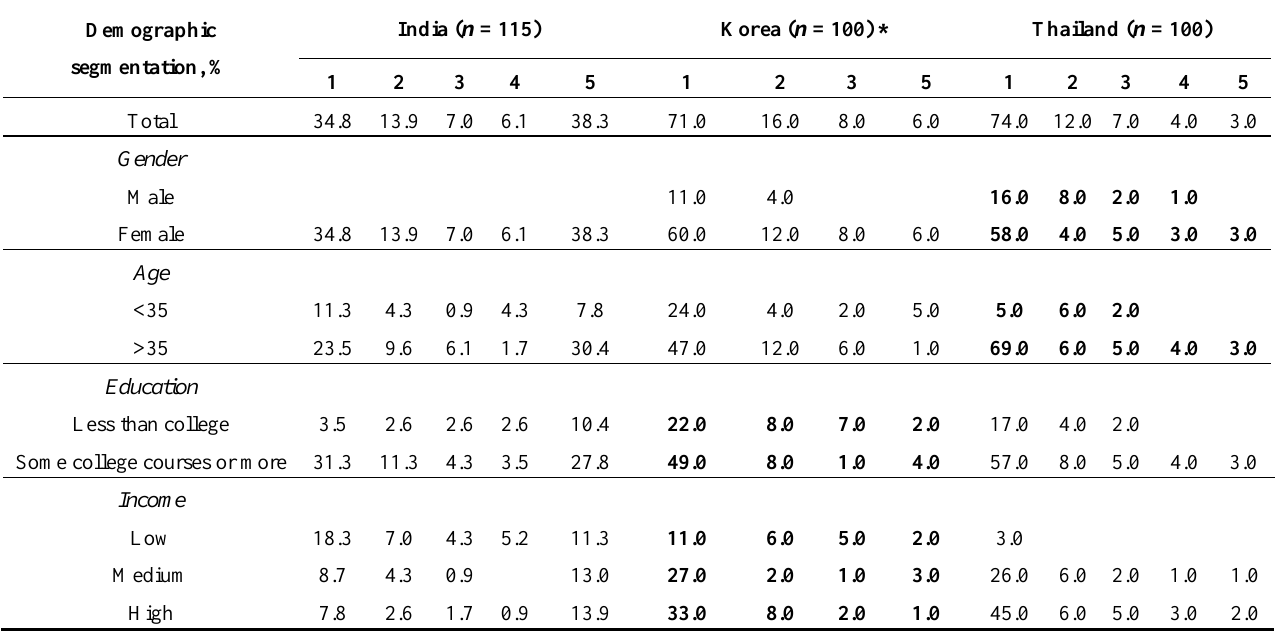
Table 11. Leftover handling practice. The last time you had leftovers from a freshly prepared salad that contained eggs or mayonnaise, how long did you let the leftovers sit at room temperature before you put them in the refrigerator or ate them later without refrigeration? Available options included: 1 hour or less (1); More than 1 hour, but less than 2 hours (2); More than 2 hours, but less than 3 hours (3); More than 3 hours, but less than 4 hours (4); 4 hours or more